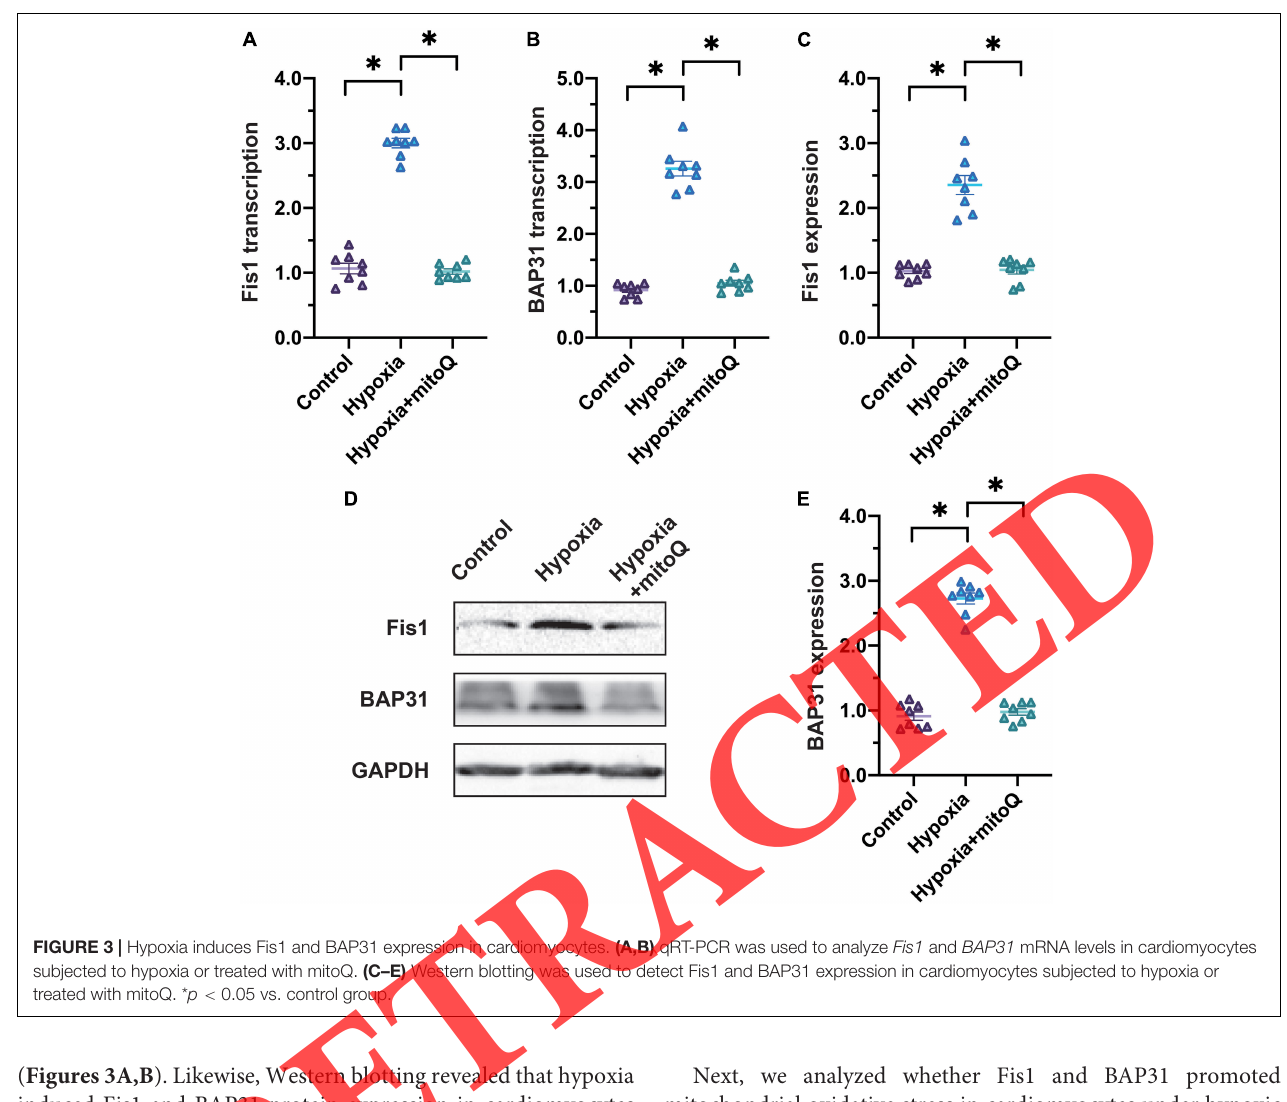
FIGURE 3 | Hypoxia induces Fis1 and BAP31 expression in cardiomyocytes. (A,B) qRT-PCR was used to analyze Fis1 and BAP31 mRNA levels in cardiomyocytes subjected to hypoxia or treated with mitoQ. (C–E) Western blotting was used to detect Fis1 and BAP31 expression in cardiomyocytes subjected to hypoxia or treated with mitoQ. * p < 0.05 vs. control